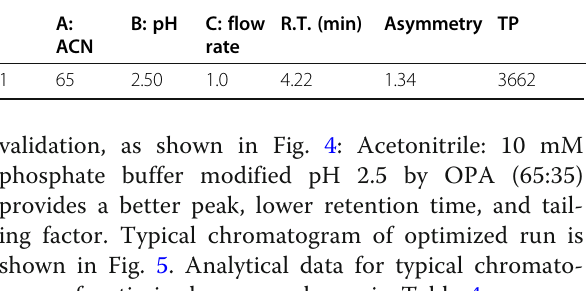
Table 4 Analytical data of optimized run Parameter